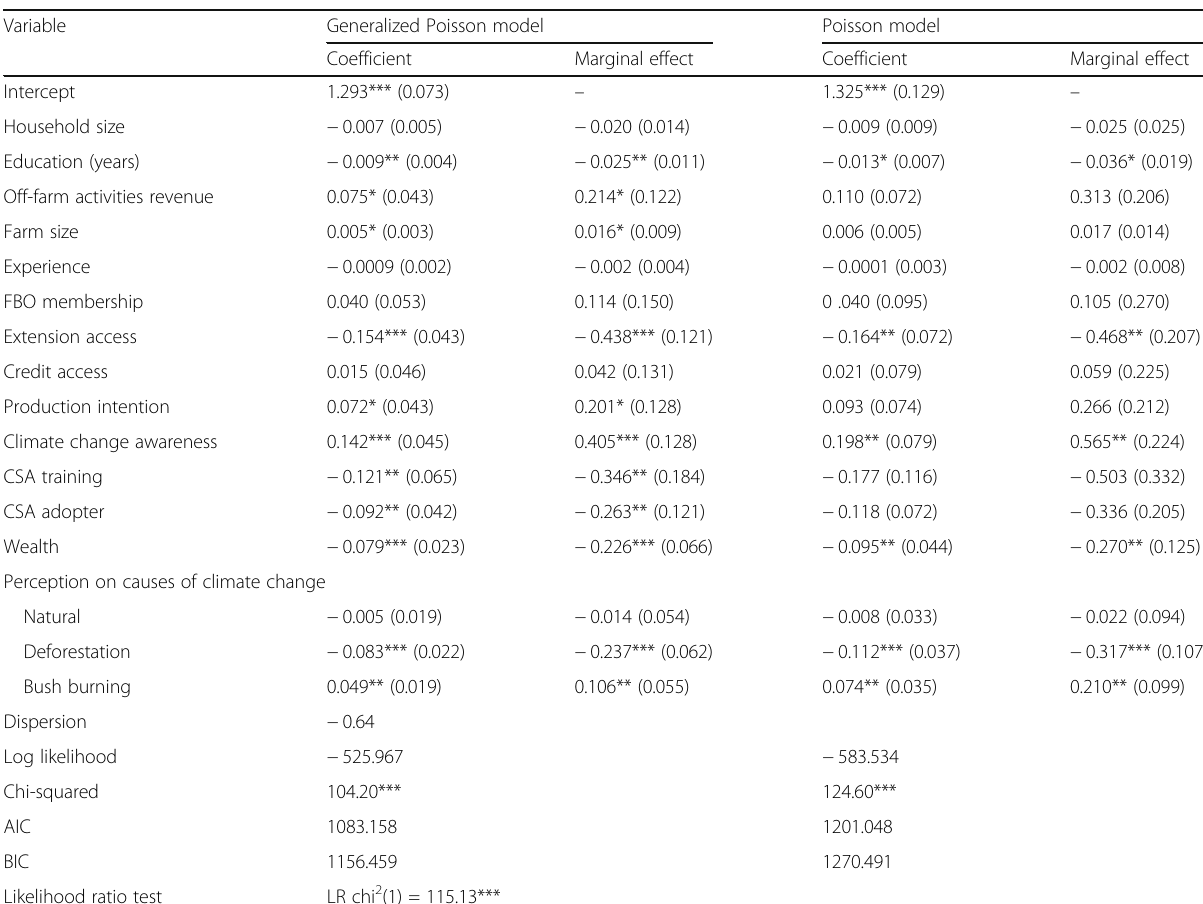
Table 5 Count data model